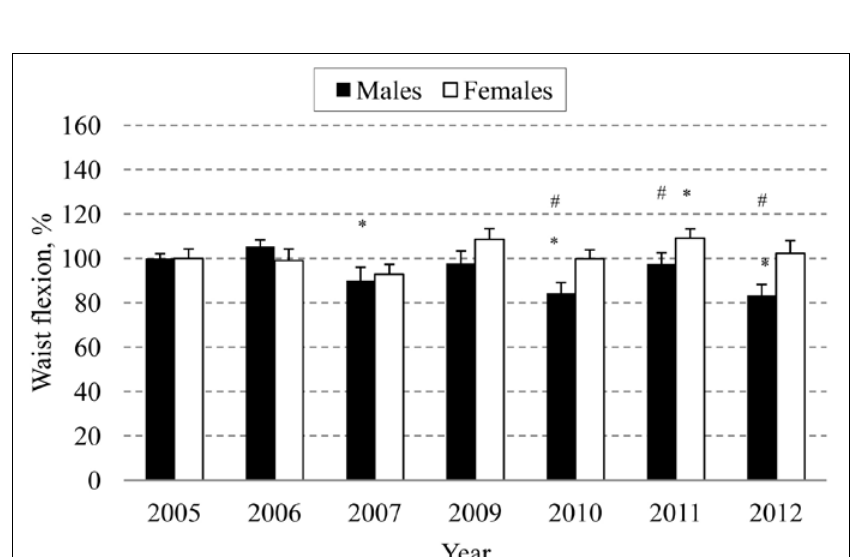
Note. * – p < 0.05 – compared to initial measurements; # – p < 0.05 – males and females compared.